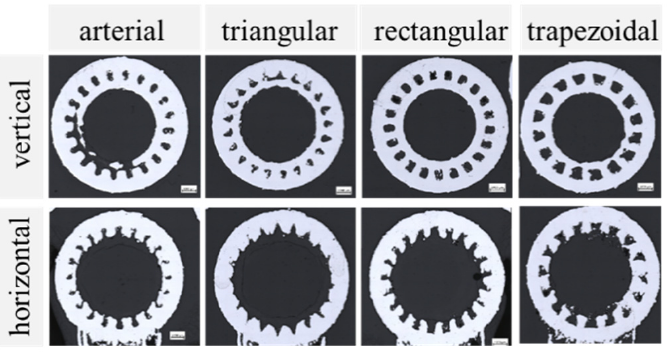
Figure 6. Optical microscopy images of grooved wicks printed vertically ( top row ) and horizontally ( bottom row ) with parameter P5 (P Contour = 300 W; v Contour = 500 mm/s). ( bottom row ) with parameter P5 (P Contour = 300 W; v Contour = 500 mm/s). For the horizontally printed wick samples, the deviations from the intended shape